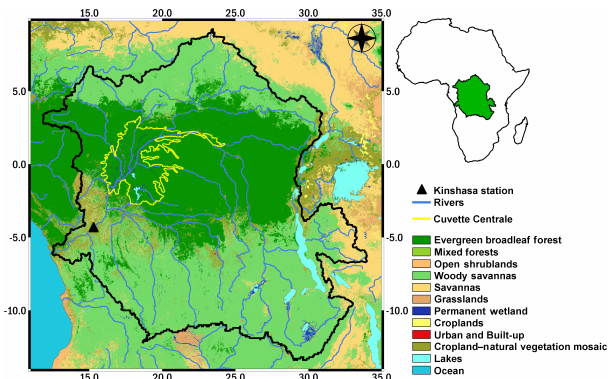
Figure 1. Geographic location of the Congo River basin, which shows the Kinshasa gauging station, the fluvial system, and the land use based on 10 years (2001–2010) (source: Broxton et al., 2014). The boundaries of the Cuvette Centrale are contoured in yellow (adapted from Betbeder et al.,